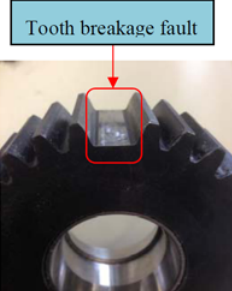
Figure 25. The photograph of tooth breakage fault in planet gear.